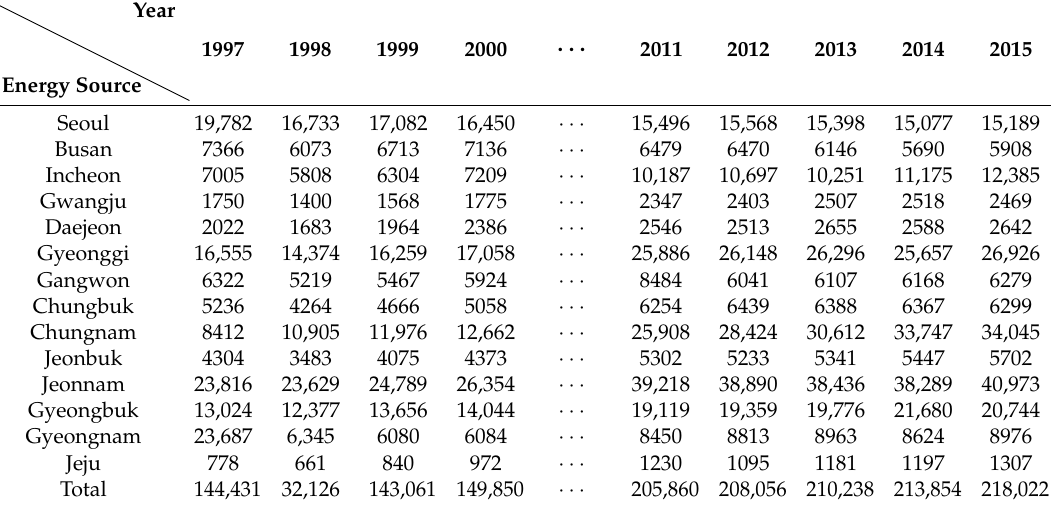
Table 2. Database of building energy consumption by